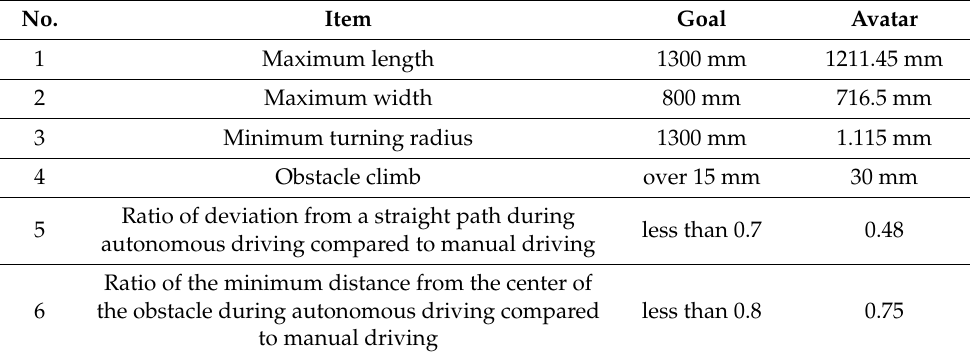
Table 1. Specifications and numerical goals of electric chair.